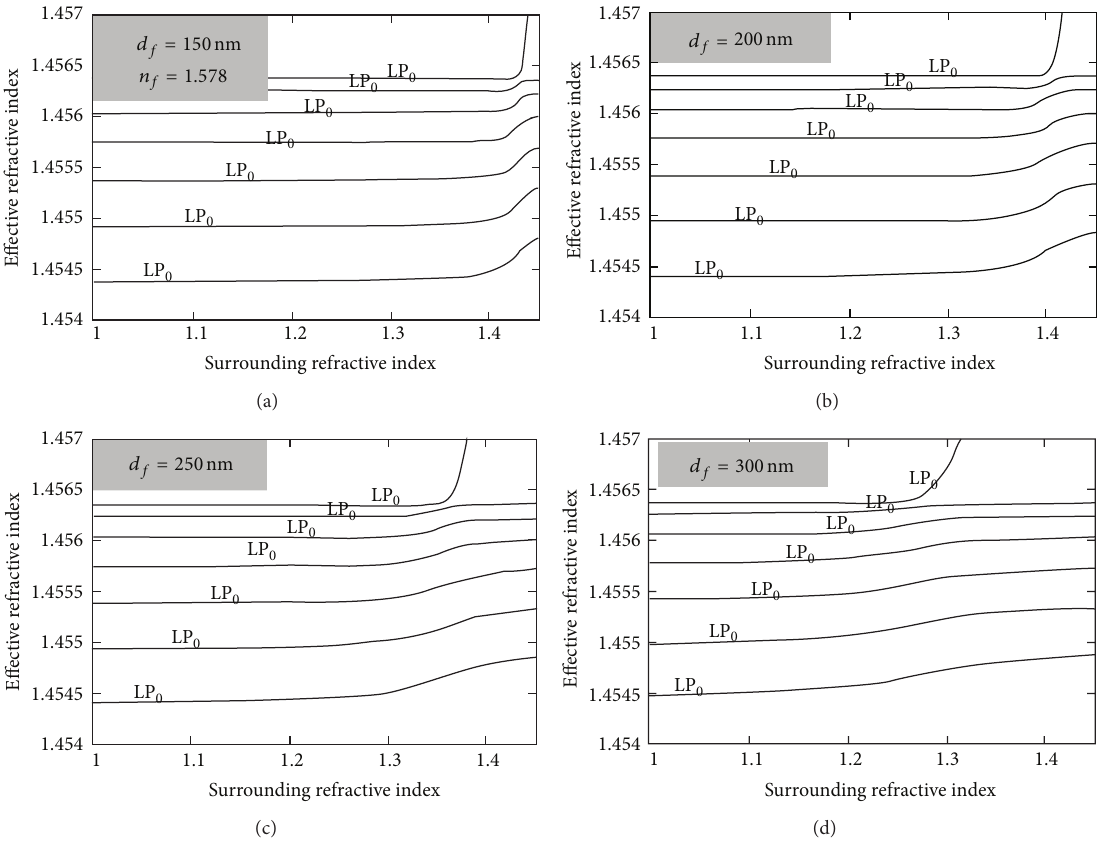
Figure 11: Dependence of the transition region on the film thickness (taken from [47]).